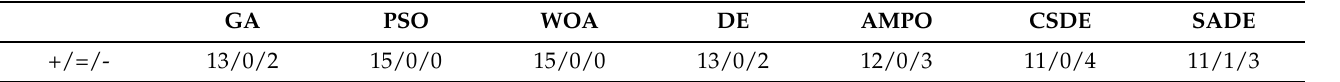
Table 3. The Significant Test on the CEC2019